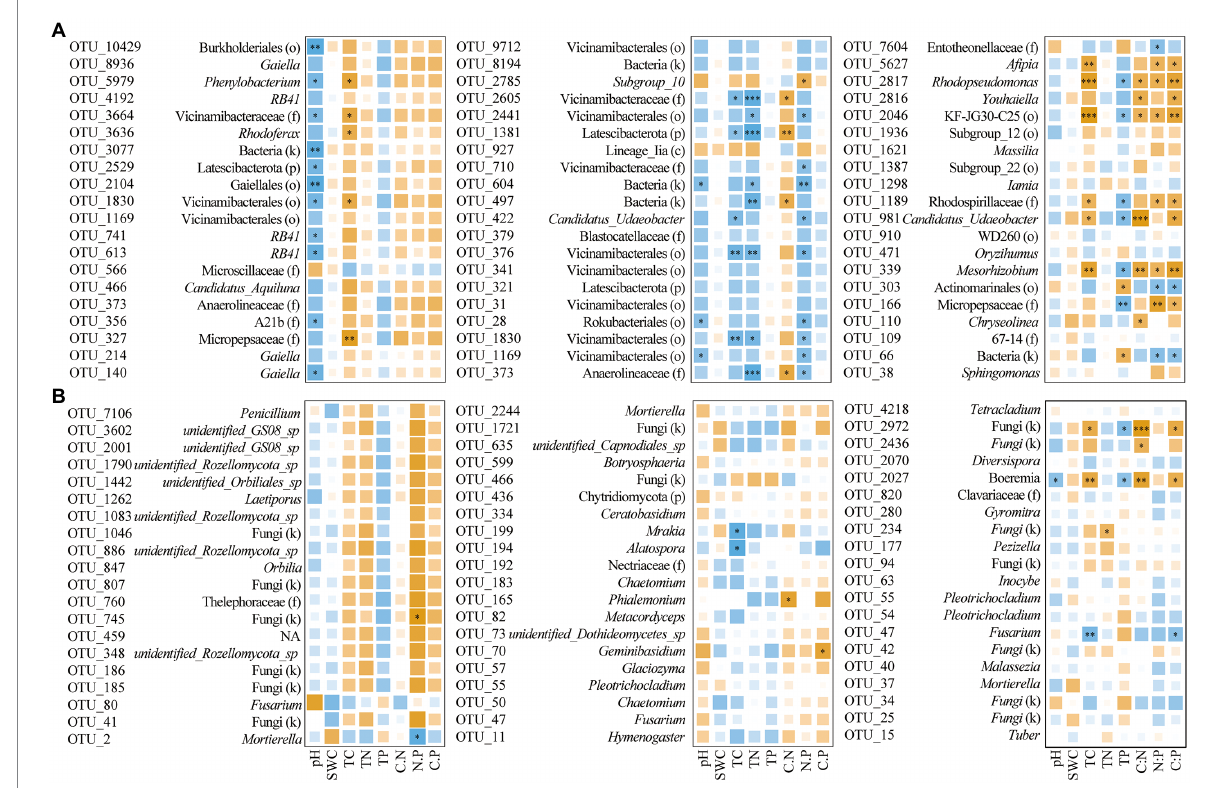
FIGURE 8 Correlation between OTU with the top 20 ° in co-occurrence networks of bacteria (A) and fungi (B) with soil physicochemical properties under forest stand differences (* p < 0.05; ** p < 0.01; *** p <